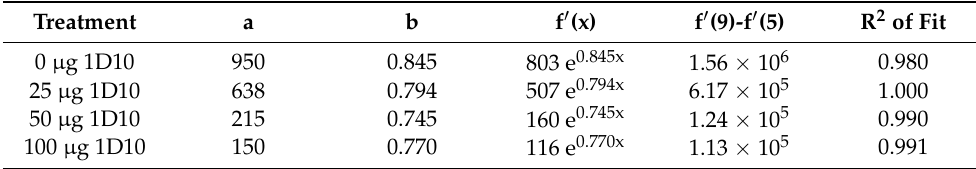
Table 2. Coefficients of fitted exponential curve between 5 h and 9 h post-infection. The exponen- tial curves have the syntax f(x) = a e bx . Additionally, the R 2 value of the fit and the derivative of the fitted functions are represented in the